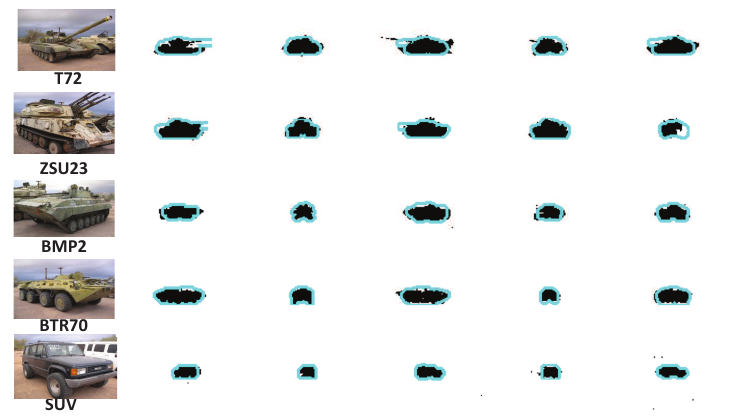
Figure 12. Segmentation results of five targets at the range of 1.5 km.